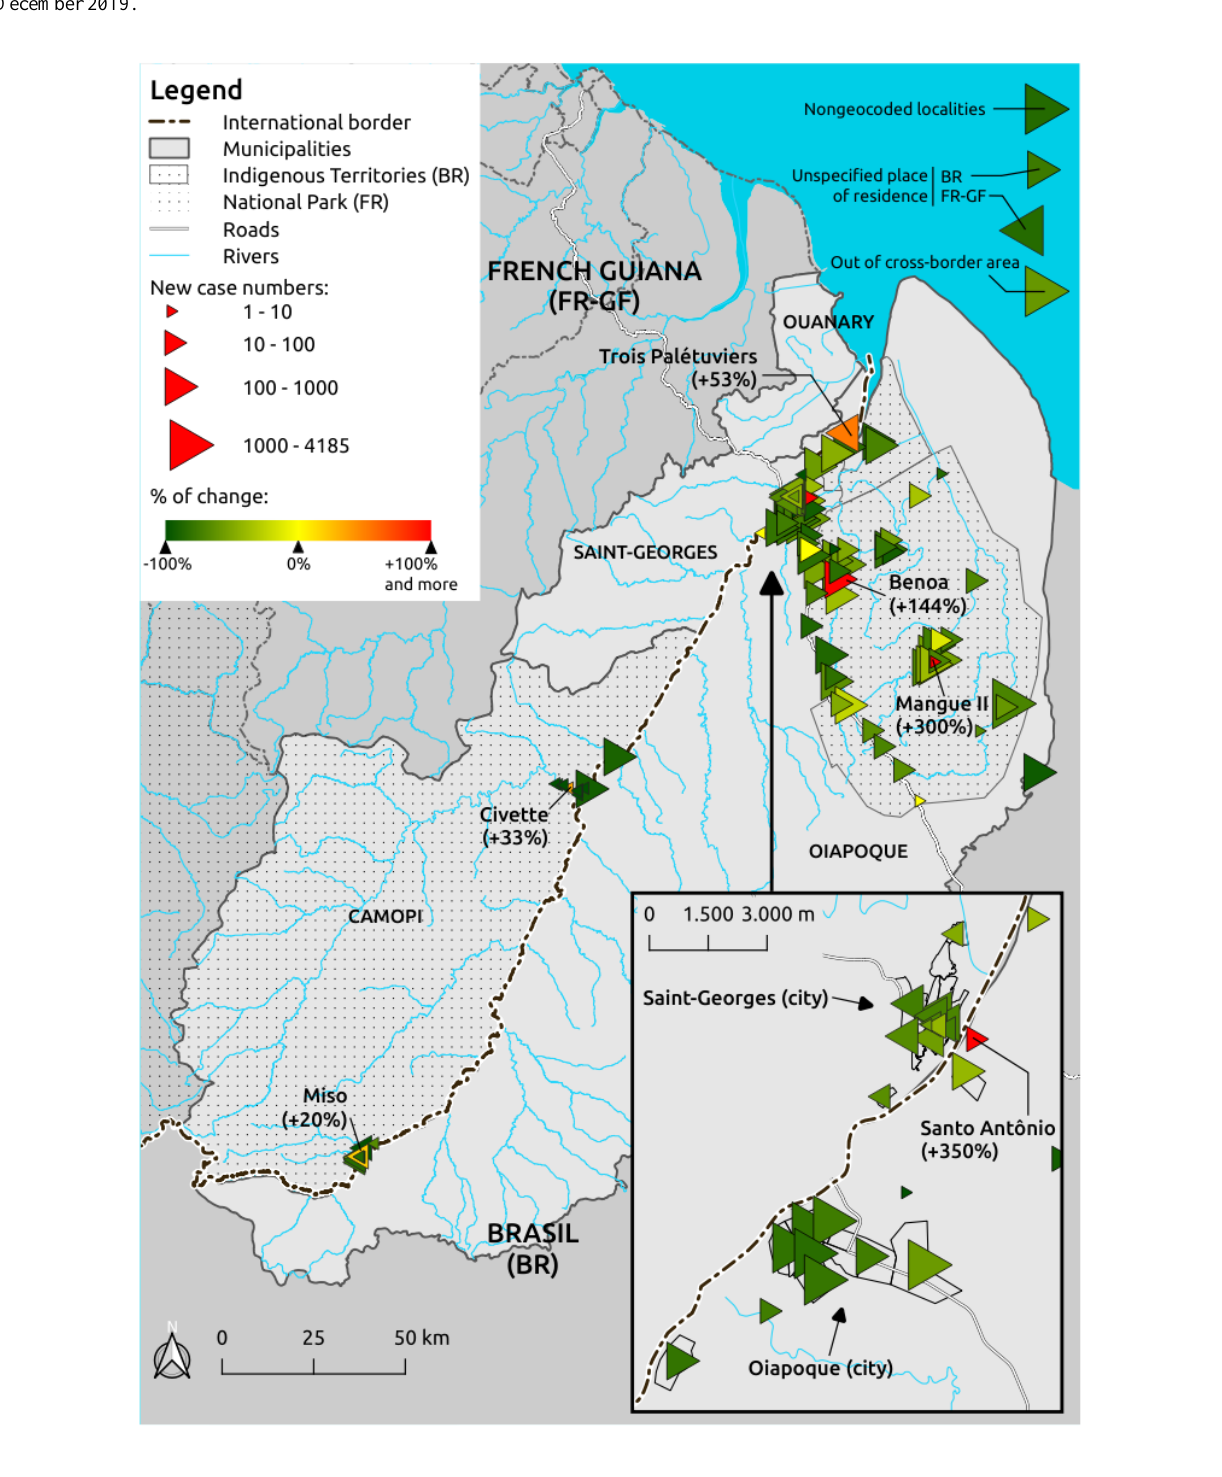
Figure 7. Number of reported malaria cases as a function of patients’ places of residence. Triangles with apexes oriented to the right correspond to Brazilian localities; triangles with apexes oriented to the left correspond to French localities. The triangle size is a function of the case number. The triangle color is a function of the percentage of change in the case number between the following two periods: January 2007 to June 2013 and July 2013 to December